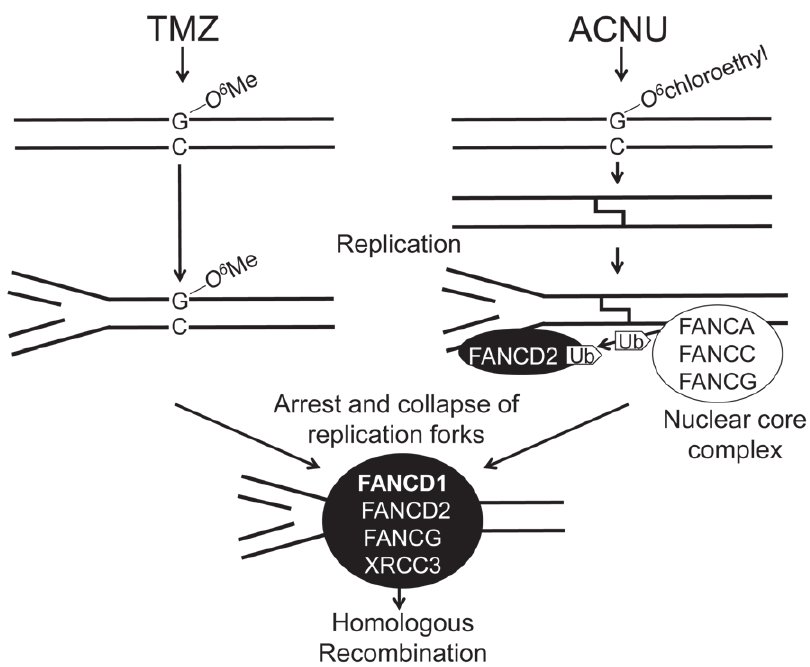
Figure 7. A schematic drawing showing a model of the repair for TMZ and ACNU induced DNA damage.